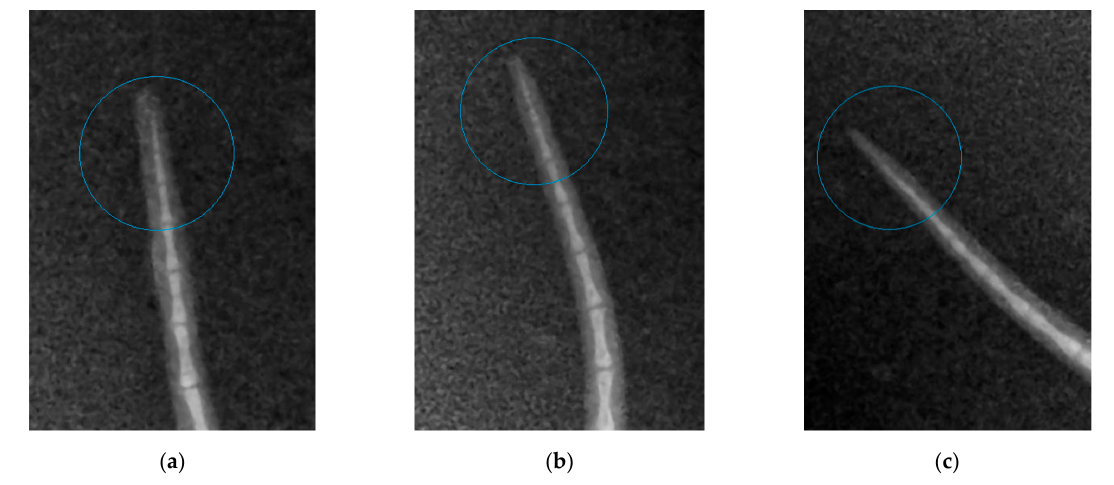
Figure 2. An X-ray image of tail vertebrae in mice: ( a ) mice receiving feed supplement containing silicon chelates (Group 1); ( b ) mice receiving feed supplement containing silicon chelates and vitamin D (Group 2); ( c ) mice receiving food without any supplements (Control group). A similar situation is revealed by analyzing the X-ray images of femoral bones (Figure 3) and calculating the cortical thickness index (Table 7).